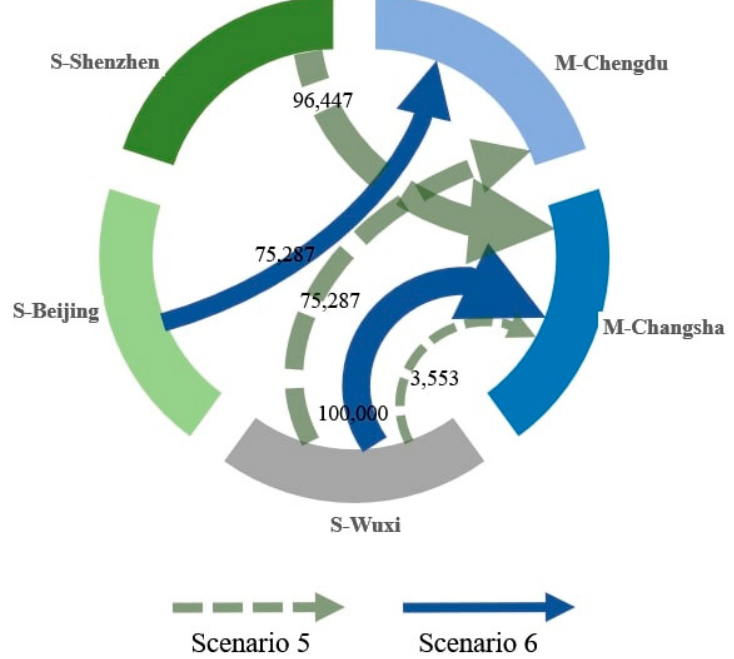
Figure 6. The solutions for Scenarios 5 and 6.